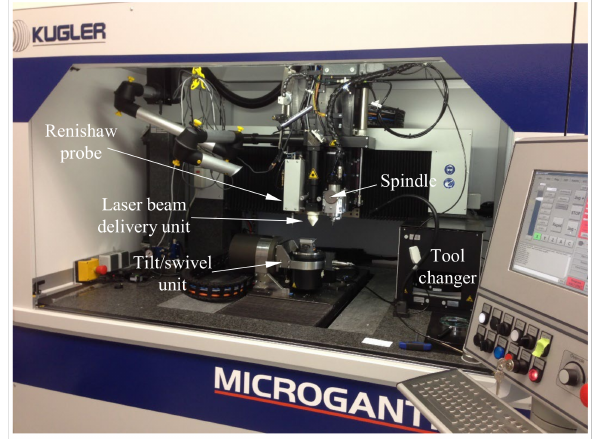
Figure 4. High precision micromachining